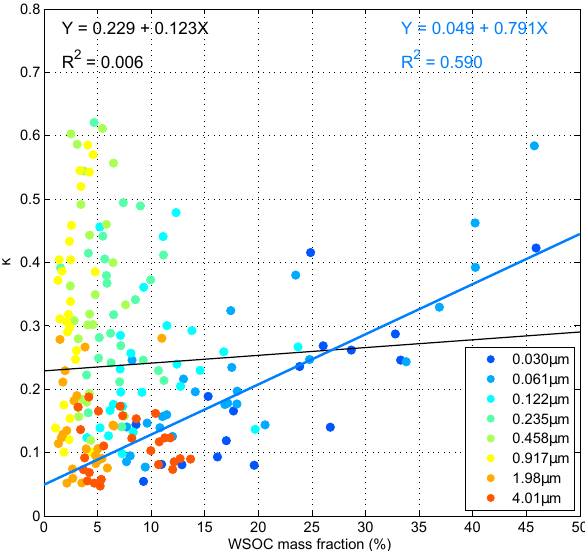
Fig. 8. The correlation between κ and the mass fraction of WSOC. Dots with the same color represent particles from the same stage. Black line shows the correlation between κ and the mass fraction of WSOC for particles from all stages, while blue line shows the cor- relation for particles smaller than 100nm. Corresponding statistic results are displayed in the top left and top right